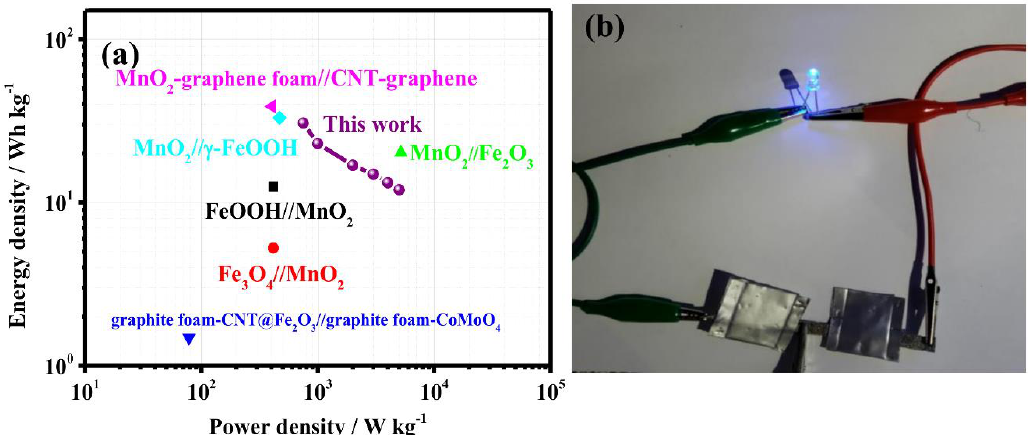
Figure 5. ( a ) Ragone plots of ASC ( b ) Digital image of blue light-emitting diodes (LED) lighted by the α-Fe 2 O 3 @C//MnO 2 ASC device.